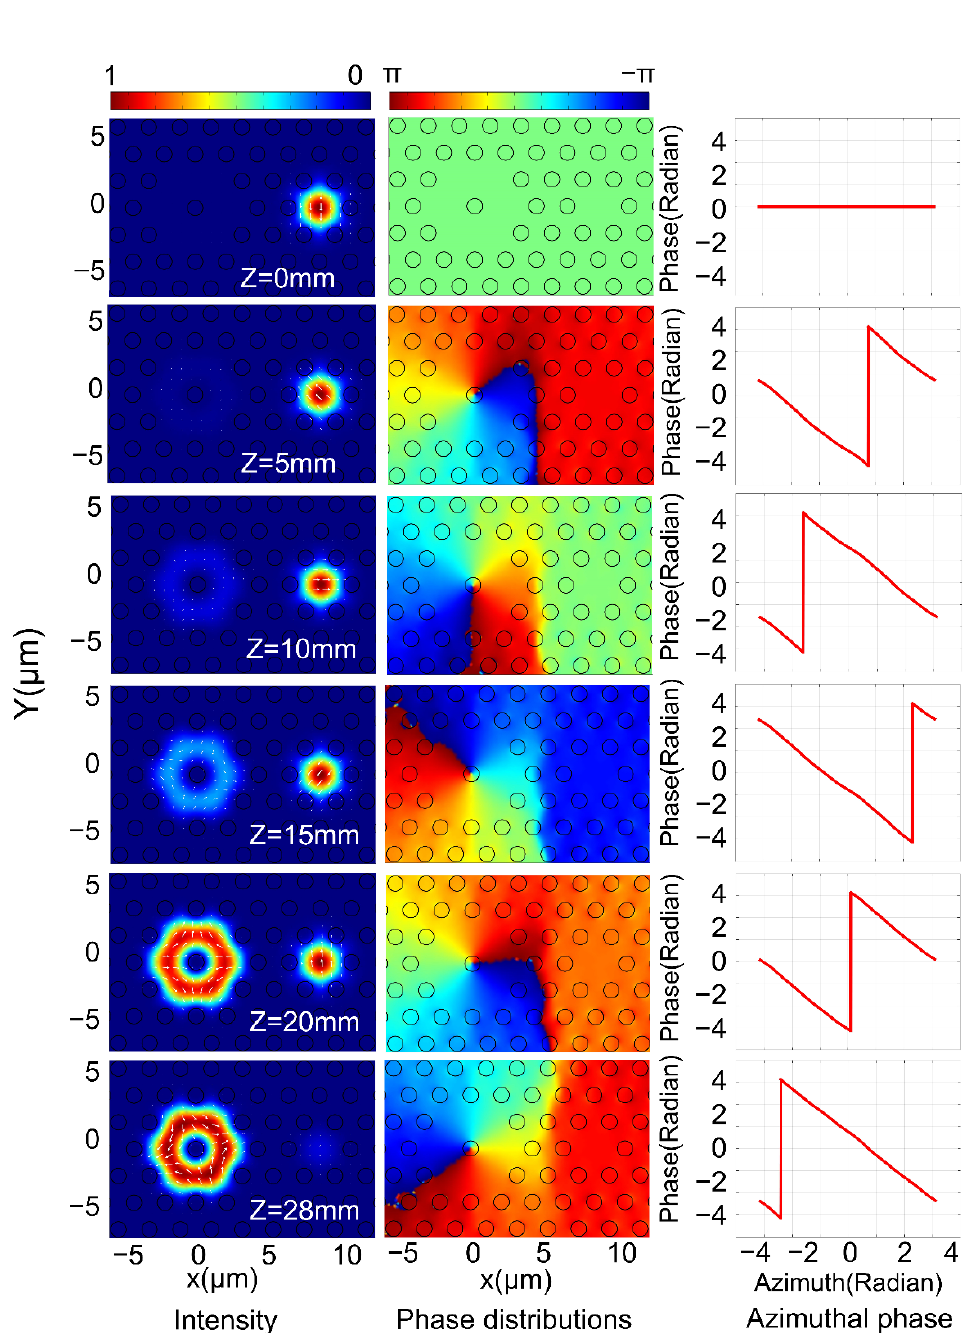
Figure 7. The intensity distribution, phase distribution and the angular phase change in the FMFC for the generated OAM − mode in FMFC at 1550 nm with Z change from 0 mm to 28 mm when the − 1 CPFM is input.